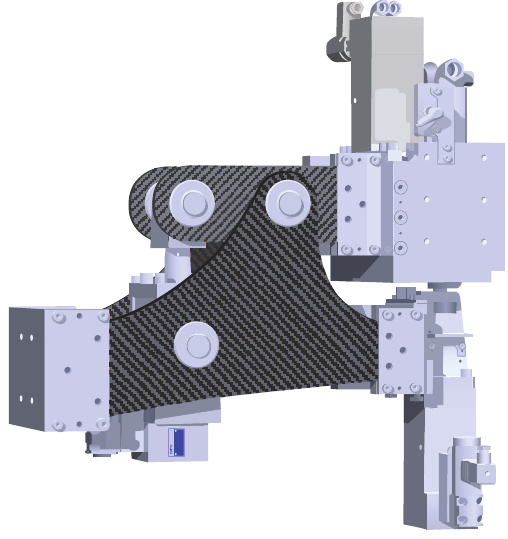
Figure 19: Novel lightweight robotic joining